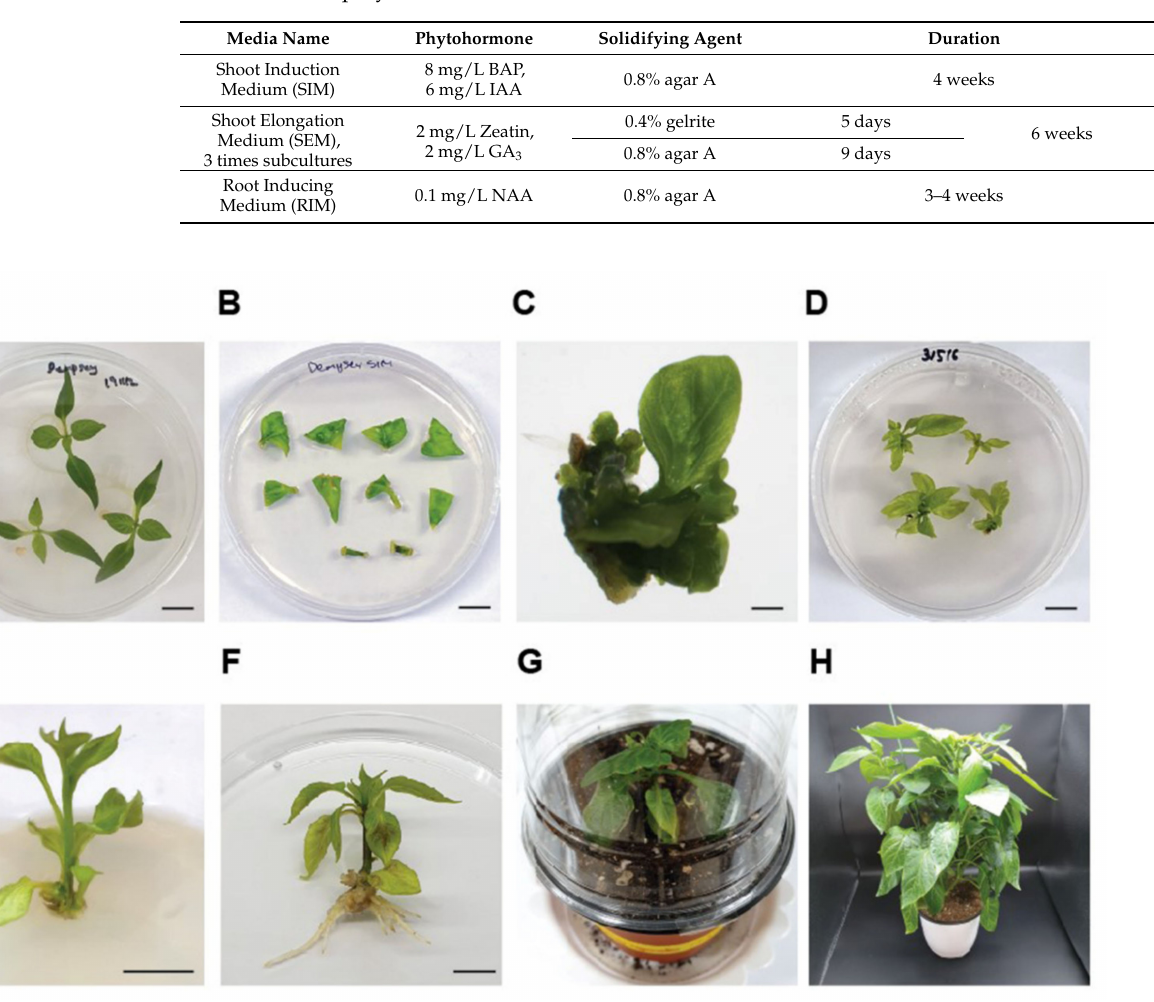
Figure 1. Whole plant regeneration procedure of bell pepper, ‘Dempsey’. ( A ) 3–4-week-old ‘Dempsey’ bell peppers were used for regeneration. ( B ) Three types of explants incubated on shoot induction medium (SIM). ( C ) Magnified image of shoot buds fully grown on SIM for 1 month, scale bar = 1 mm. ( D ) Elongated shoot buds on shoot elongation medium for 6 weeks. ( E ) A grown shoot on root induction medium (RIM). ( F ) Regenerated ‘Dempsey’ with protruded roots before soil-transplanting, scale bars ( A – E , except C ) = 1 cm. ( G ) Acclimation of peppers with a transparent plastic lid for two weeks after soil-transplanting, 9 cm diameter of pot. ( H ) Fully-grown ‘Dempsey’ regenerant, 15 cm diameter of